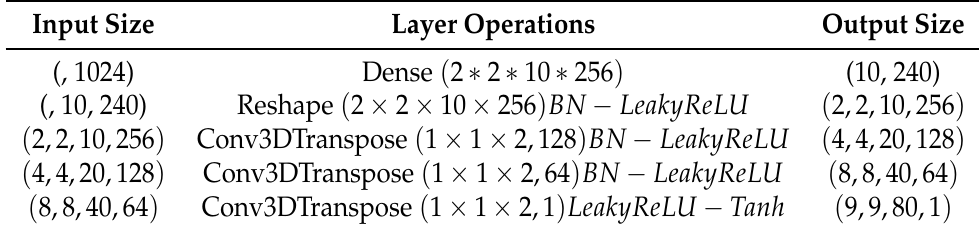
Table 3. The implementation details of spectral Generator G 1 .